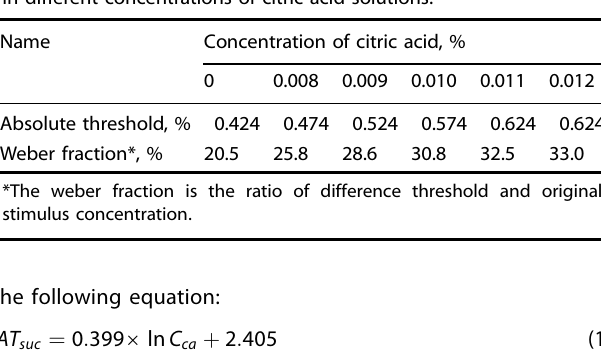
Fig. 1 Sucrose taste sensation curves in different concentration of citric acid solutions. a Showed the sweet sensory difference strength of sucrose; b showed the relationship between sucrose absolute threshold value and citric acid concentration; c showed the relationship between sucrose Weber fraction and citric acid concentration. Table 1. The absolute threshold values and weber fraction of sucrose in different concentrations of citric acid solutions.